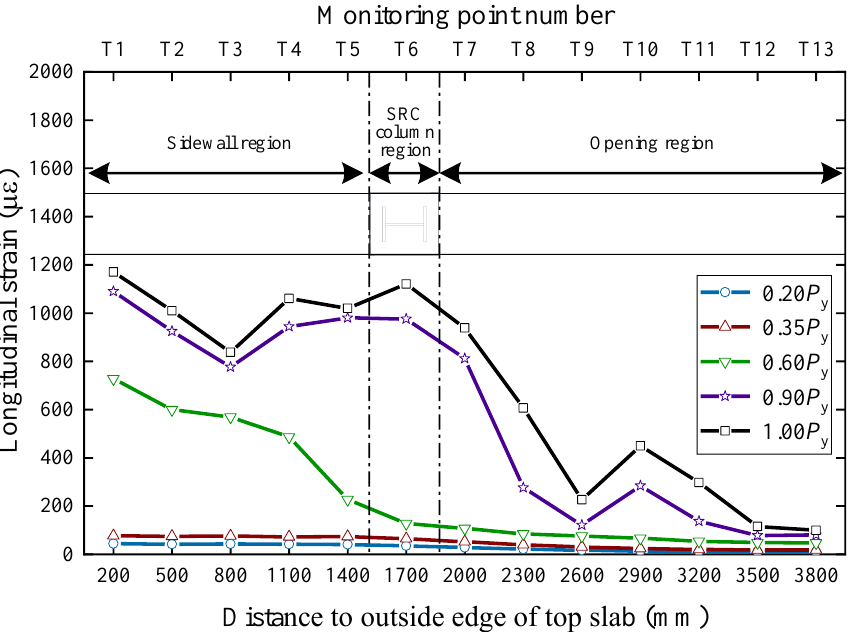
Figure 14. Strain distribution of the longitudinal reinforcement at the top slab end.